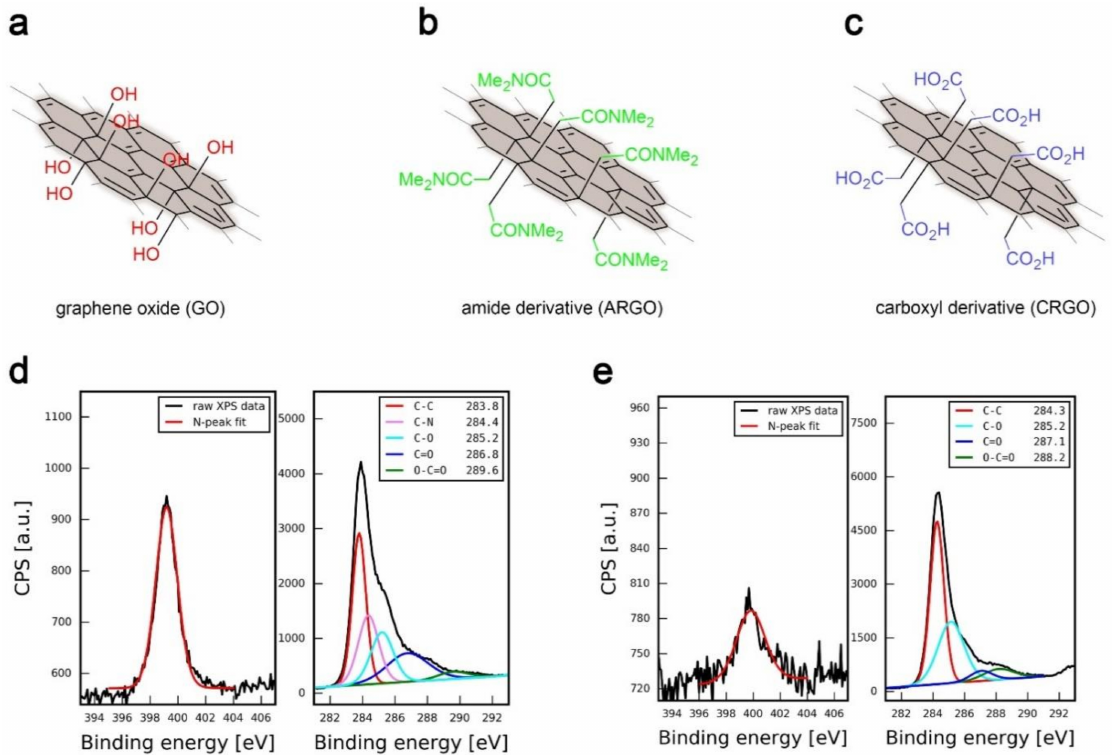
Figure 1. Schematic representation of graphene materials: ( a ) graphene oxide (GO), ( b ) amide derivative of reduced graphene oxide (ARGO), and ( c ) final product, carboxyl derivative of reduced graphene oxide (CRGO). Along the structures, results of high resolution X-ray photoelectron spectroscopy (XPS) analysis of nitrogen and carbon peak regions are shown for ( d ) amide derivative (ARGO) and ( e ) carboxyl derivative (CRGO) of reduced graphene